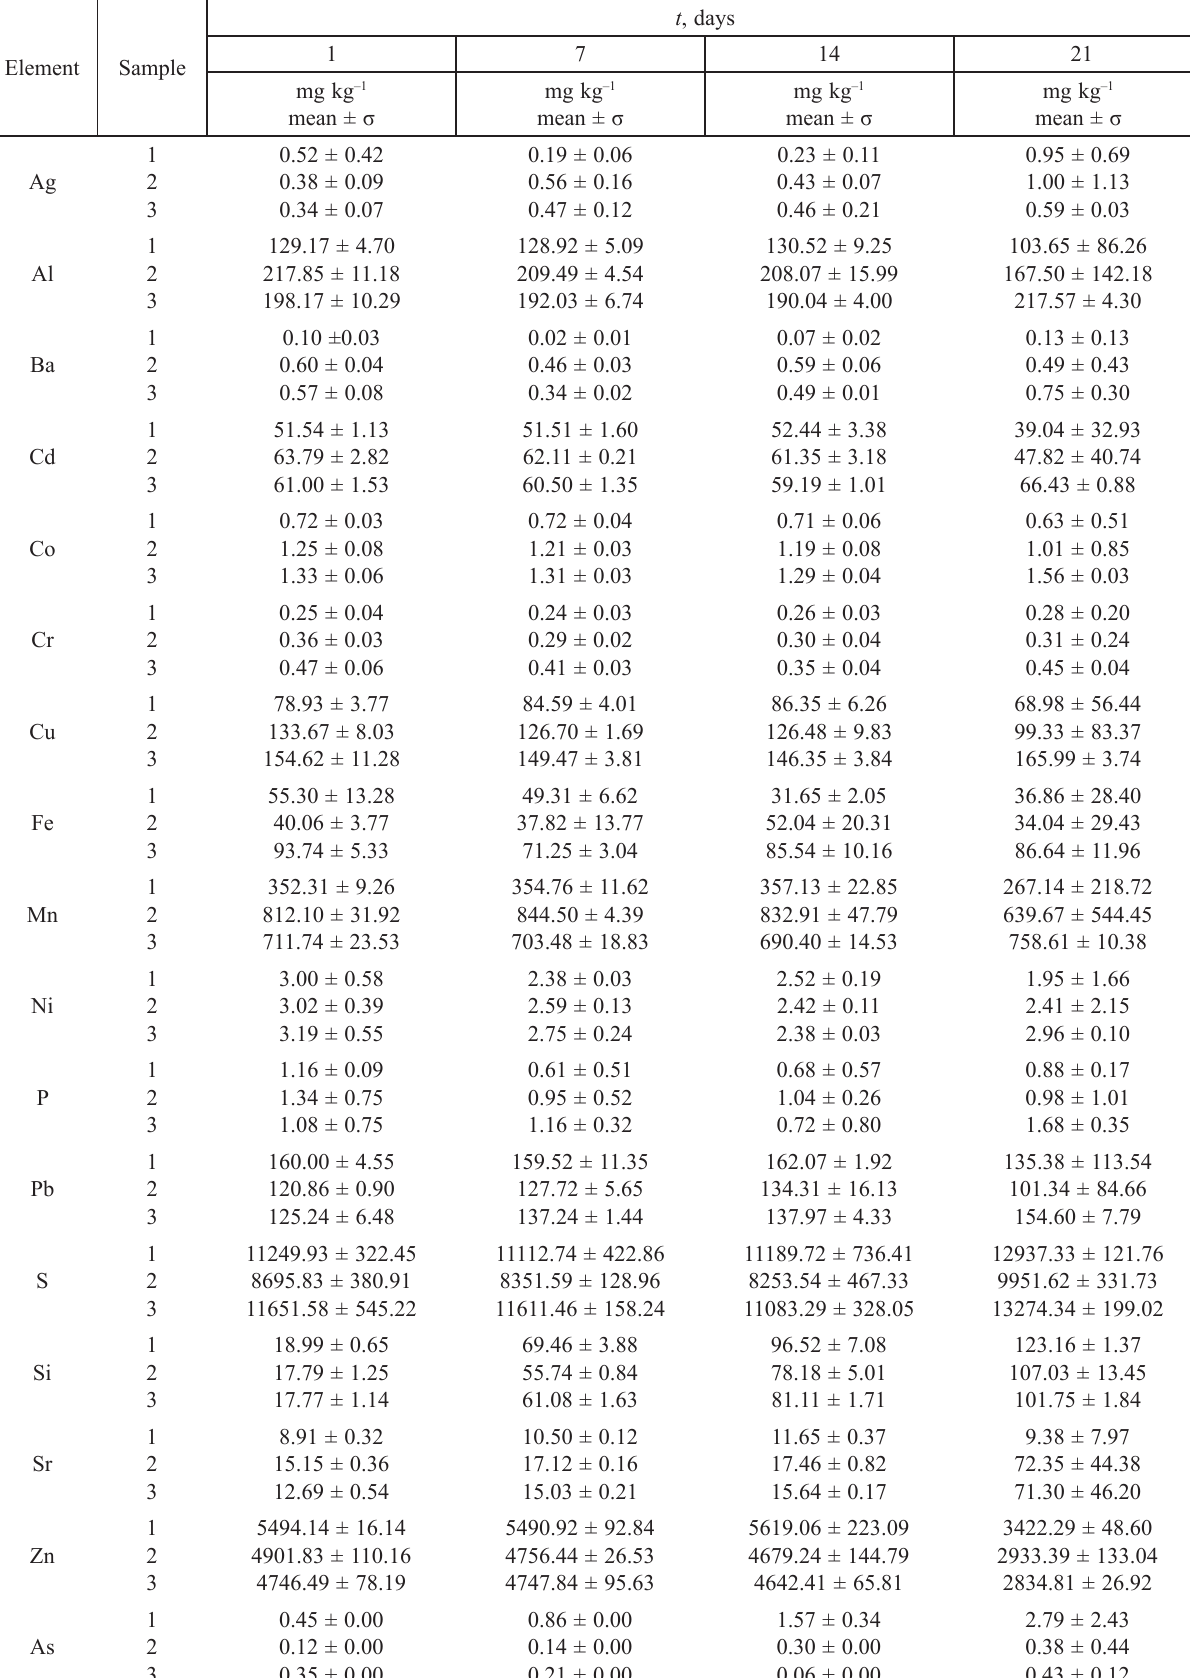
Table 3 – Average concentration of major and minor elements in samples leached with synthetic acid rain leaching tests